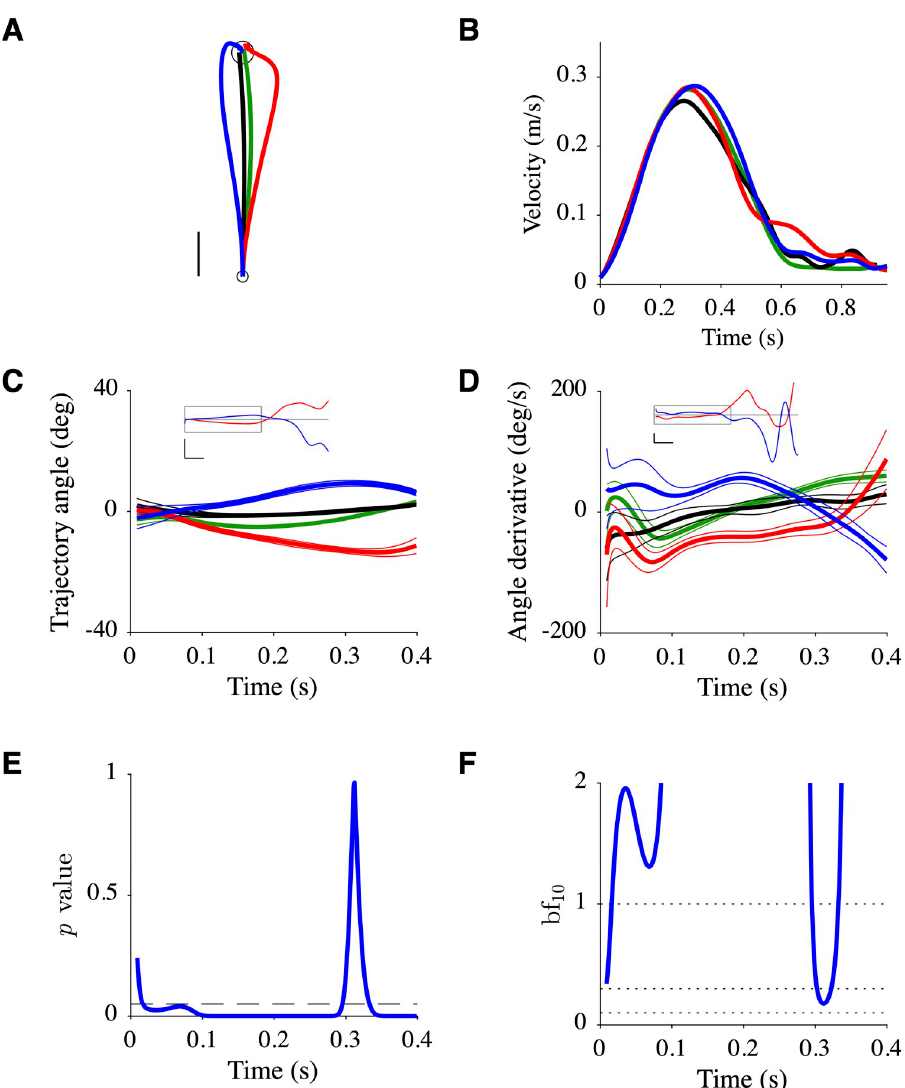
Fig 6. Data of participant P5. Same organization as Fig 5 with C , D , E , F corresponding to E , F , G , H .